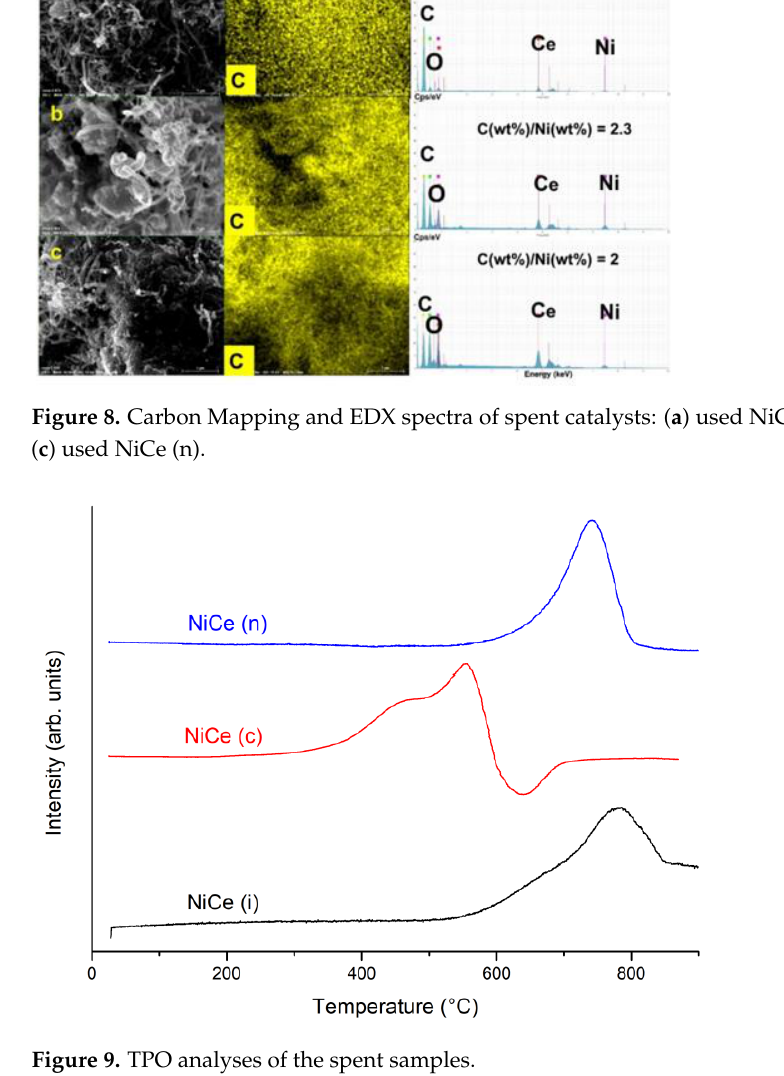
Figure 9. TPO analyses of the spent samples.